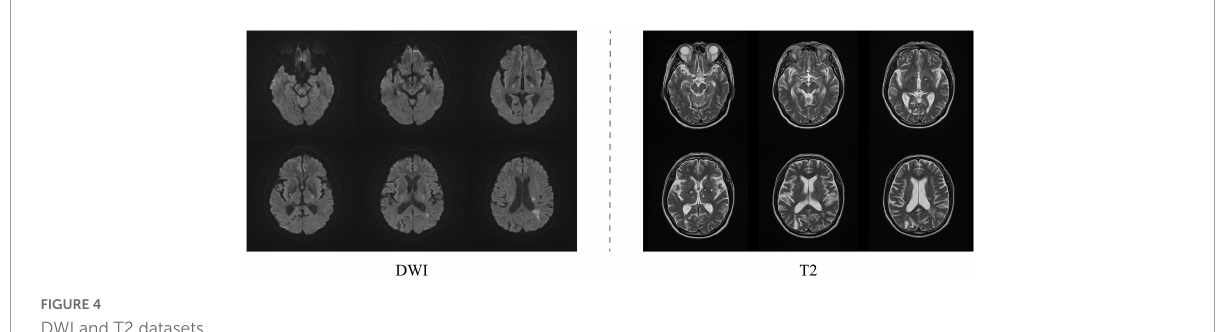
FIGURE4 DWI and T2 datasets.